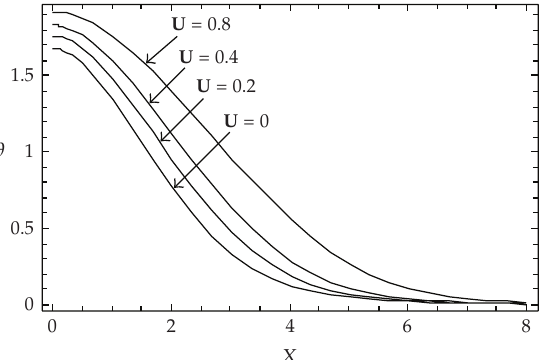
Figure 8: Dimensionless temperature distributions with dimensionless velocity of the medium from the hyperbolic model for the exponential heat source ; φ (cid:3) η (cid:4) (cid:5) exp (cid:3) − 0 . 4 η (cid:4) , ψ